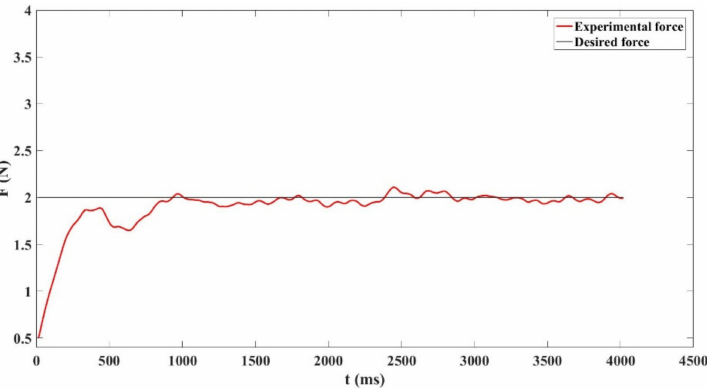
Figure 10. Robotic magnetorheological polishing force response at 14.3% magnetorheological moisture.